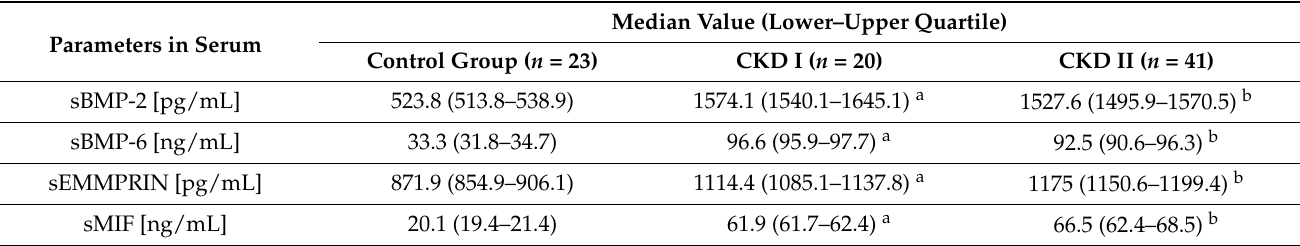
Table 2. Serum concentrations of examined parameters in children with CKD and in the control group.